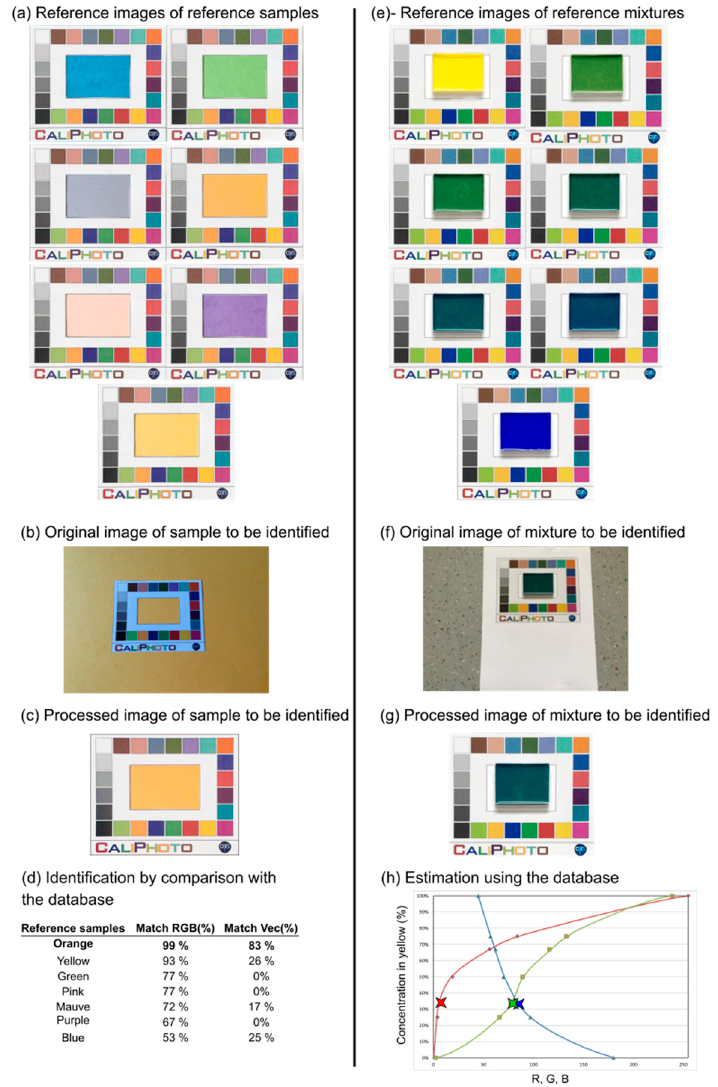
Figure 5. On the use of the CaliPhoto method for sample identification and for compositional measurement. ( a – d ) Example of identification process using coloured paper. ( a ) Reference images of reference samples constituting the database obtained after CaliPhoto image processing. ( b ) Original image of the sample to be identified. ( c ) Processed image of the same sample. ( d ) Table reporting the percentage match using RGB values ( M = 1 − ∆ 12 ) or the CaliPhoto colour vectors ( M = 1 − ∆ Vec 12 ). The sample is demonstrated to be the orange object. ( e – h ) Example of the use of the CaliPhoto method to estimate the concentration in a mixture of two paints. ( e ) Reference images of reference samples of known concentration used for the database, obtained after CaliPhoto image processing. ( f ) Original image of the mixture to be determined. ( g ) Processed image of the same mixture. ( h ) The concentration of yellow paint can be estimated from the curves displaying changes in the CaliPhoto RGB values for the known mixtures. The estimated concentration of yellow paint is approximately 33% ± 5%, whereas the true concentration was 29% ± 1%.